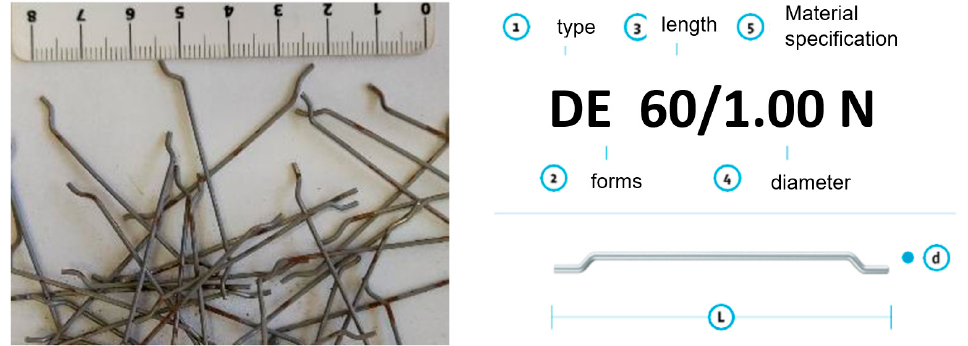
Figure 3. Detail of fibres used in the samples (KrampeHarex, 2020); 1—type; 2—forms; 3—length; 4—diameter of fibre; 5—specify of materials; L—length; d—diameter of fibre.